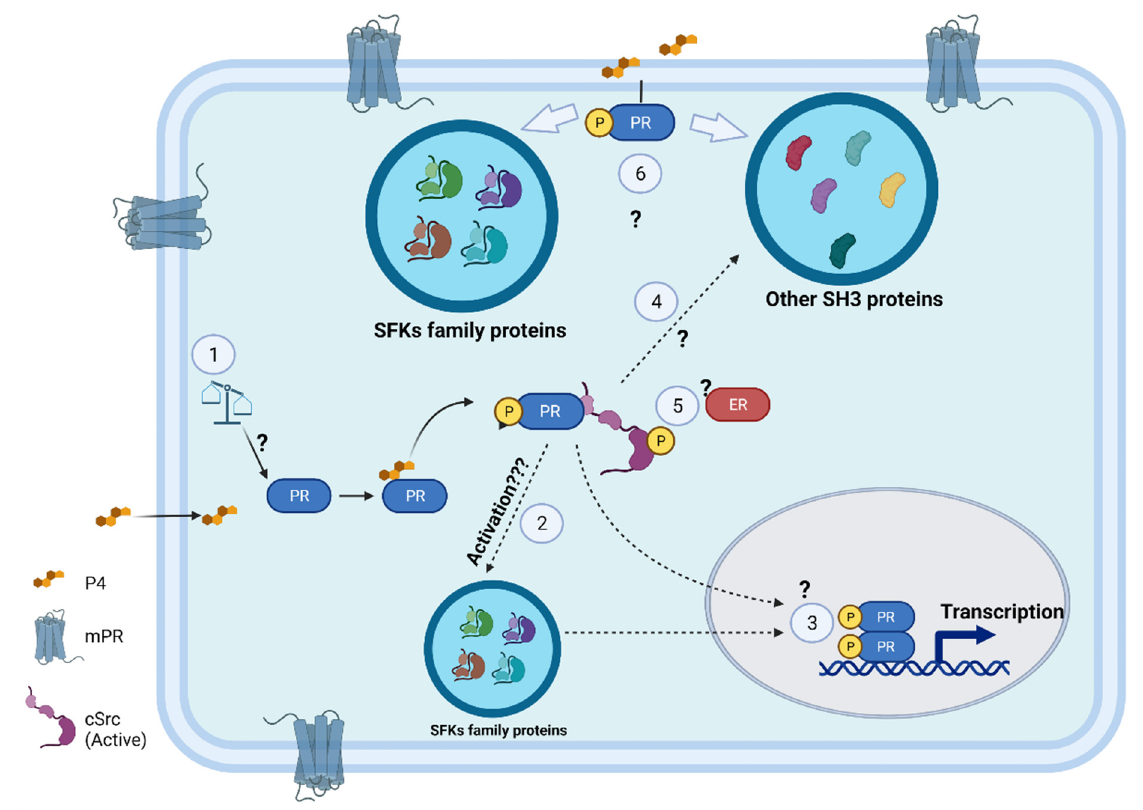
Figure 2. Potential extranuclear effects of PR. In breast cancer cells, cSrc kinase has been reported to bind PR through SH3–PXPP interaction. This interaction promotes the activation of cSrc by a conformational change that exposes the tyrosine residue 416. Other SH3-domain proteins could interact with the PR. Although its main localization is nuclear and cytoplasmic, the PR has been found to be anchored to the plasma membrane. However, there is still a lack of knowledge about many of the proteins and effects involved in the extranuclear signaling of the receptor. 1: What role does P4 concentration play in the induction of rapid PR effects? 2: What other kinases of the SFKs family can be activated by their interaction with the PR? 3: What is the role of cSrc and other SFKs in PR phosphorylation? 4: Which other proteins with SH3 domains can interact with the PR, and what effects are triggered? 5: In what context is the ER essential for the activation of cSrc through the PR? 6: What are the mechanisms allowing PR anchoring to the plasma membrane? What protein complexes would form in this area? Furthermore, is this PR localization essential for extranuclear signaling?